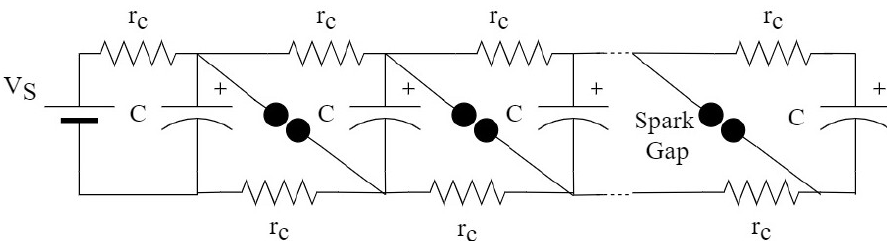
Figure 4. Conventional Marx